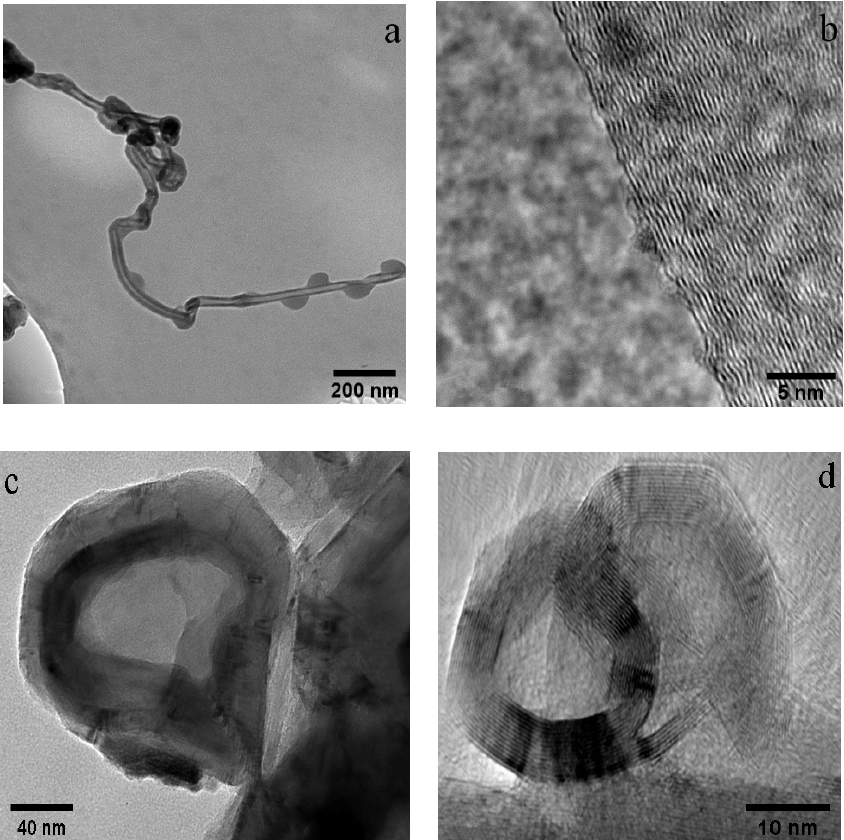
Figure 2. TEM and HR-TEM images of CNTs ( a , b ) and CNOs ( c , d